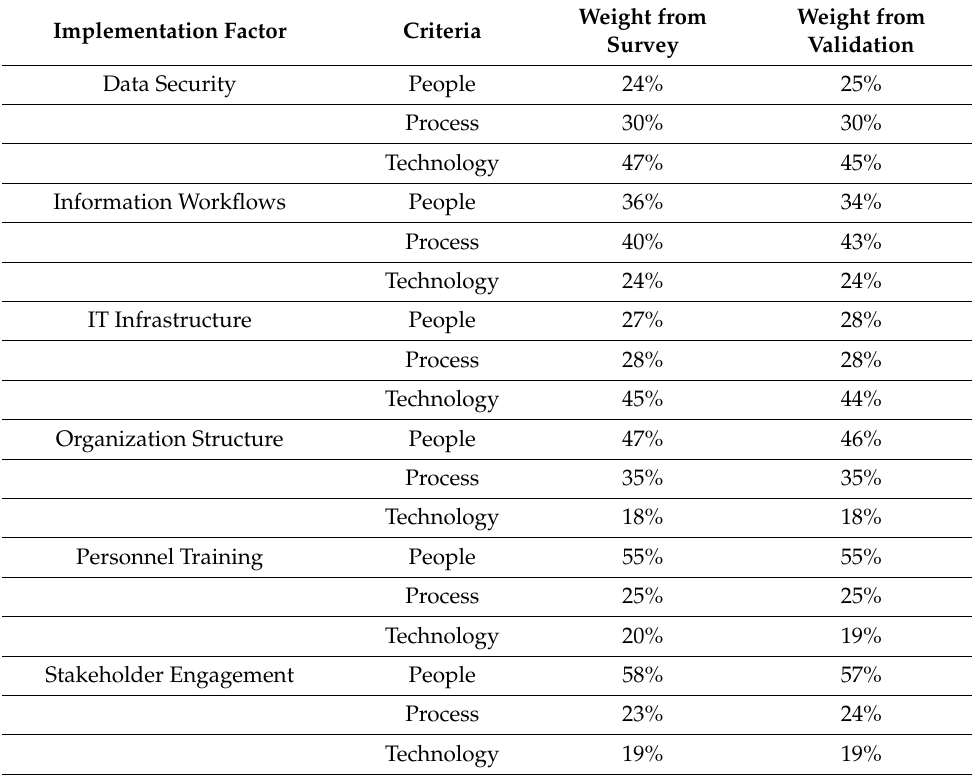
Table 6. Weight of People, Process, and Technology from the survey and workshop